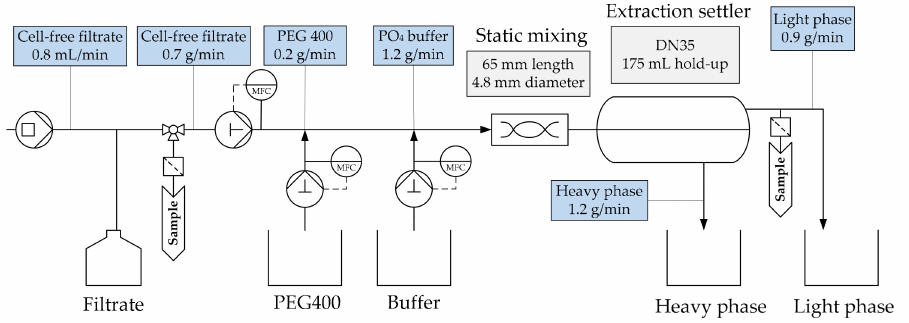
Figure 10. Schematic overview of the ATPE (aqueous two-phase extraction) process.